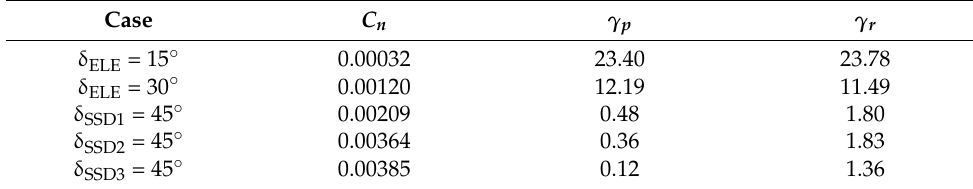
Table 5. Comparison between the elevon and SSDs at α = 6 ◦